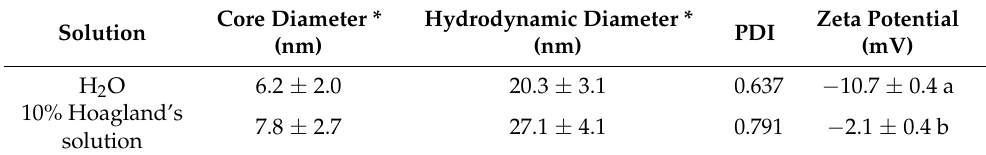
Figure 3. Size distribution of AgNPs in distilled water ( A ) and 10% Hoagland’s solution ( B ). Table 2. Core diameter, hydrodynamic diameter, polydispersity index (PDI) and Zeta potential of AgNPs in distilled water (A) and 10% Hoagland’s solution (B). Data represent the mean ± SD ( n = 5). Data with different letters are significantly different ( p <